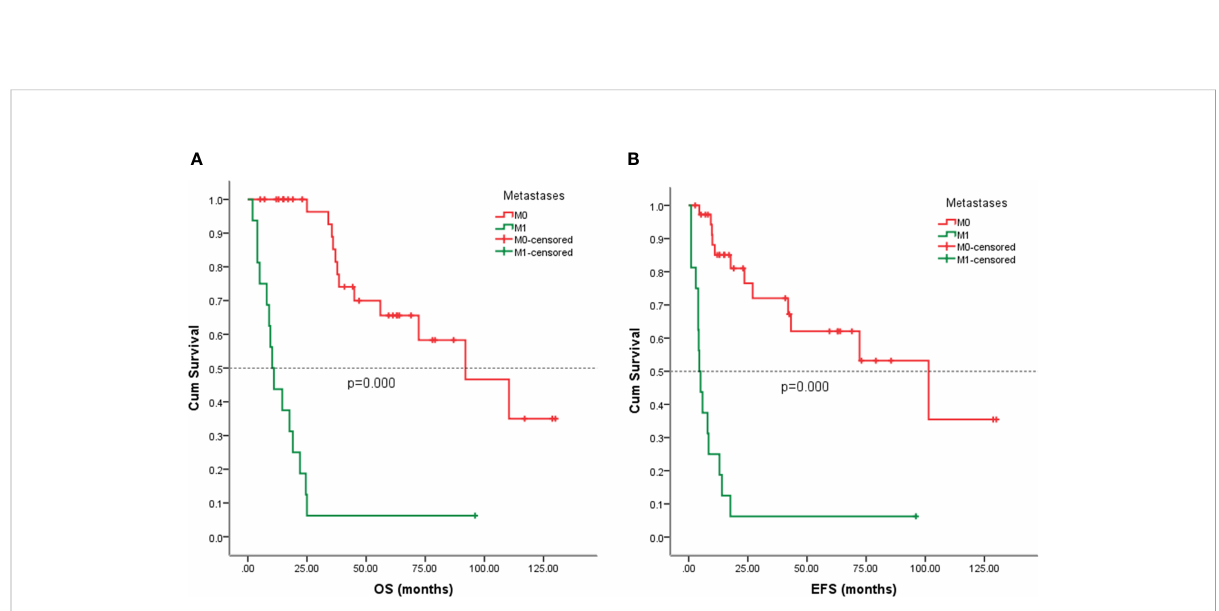
FIGURE 3 Kaplan-Meier analysis of OS and EFS for patients with or without metastasis at presentation. (A) Kaplan-Meier analysis of OS for patients with or without metastasis at presentation (p=0.000). (B) Kaplan-Meier analysis of EFS for patients with or without metastasis at presentation